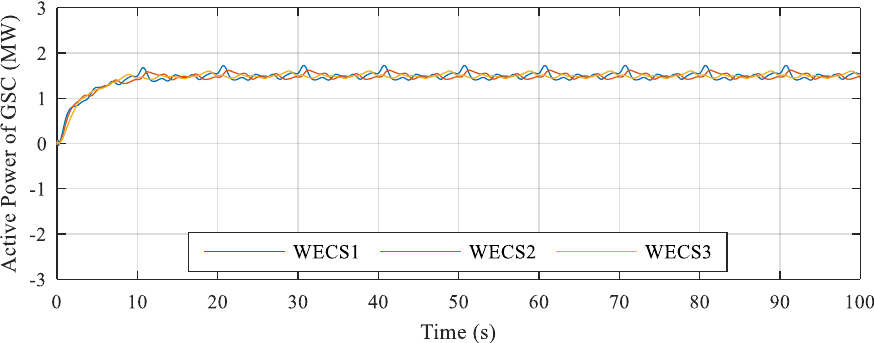
Figure 15. Active power of grid-side converter without proposed controller (Case 2).